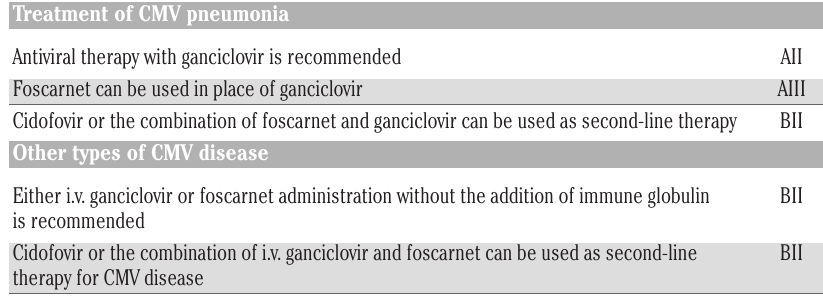
Table 3. Cytomegalovirus